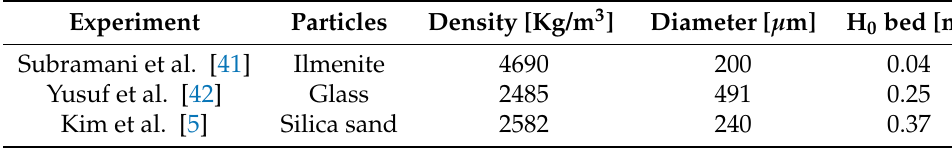
Table 1. Experimental conditions for the test cases.